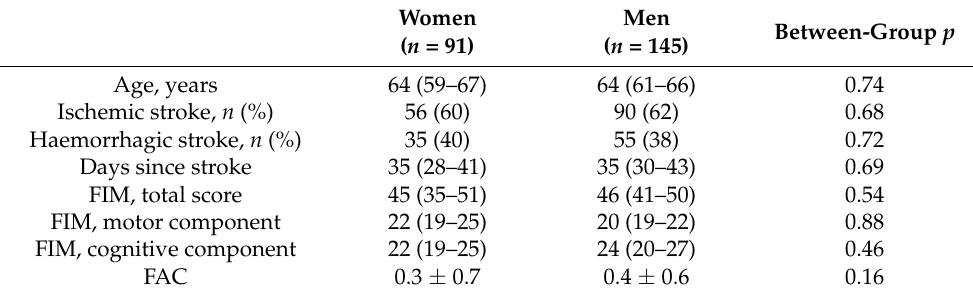
Table 1. Characteristics of the two groups of patients at hospital